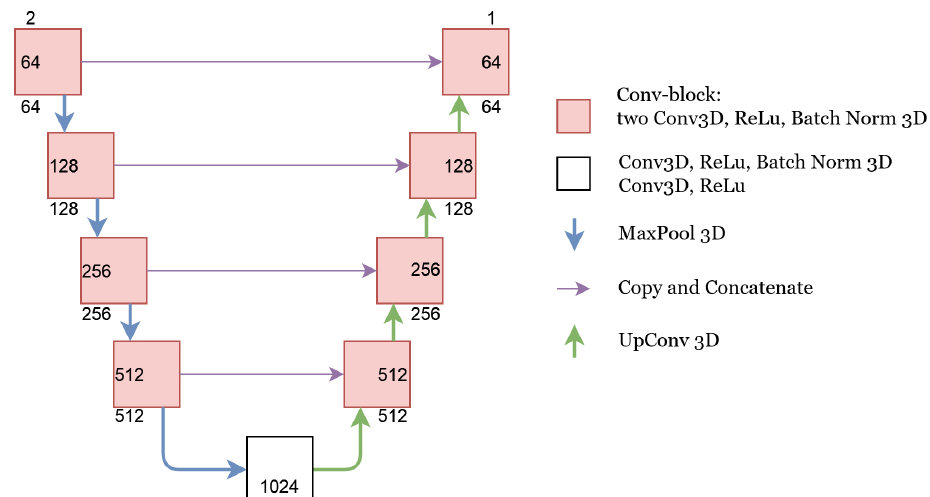
Figure 1. U-Net architecture. The number of input and output channels to each conv-block is depicted on the outside of the conv-block box. The number inside the conv-block box shows the number of channels after the first Conv3D operation.